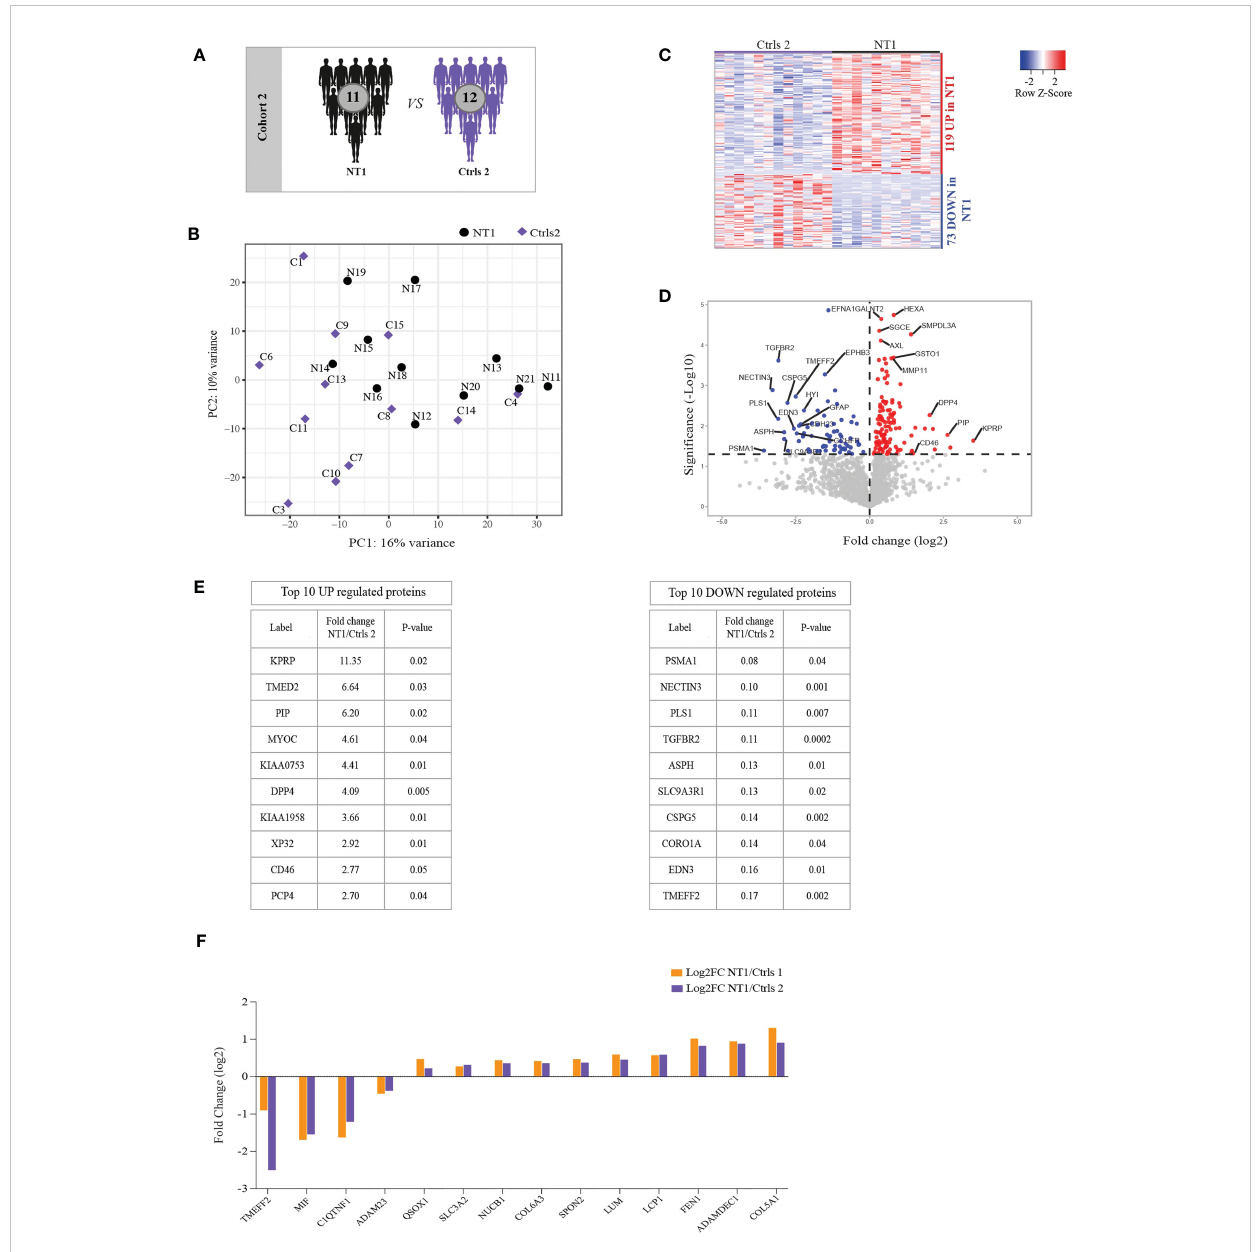
FIGURE 2 Differentially regulated proteins in the CSF of persons with NT1 compared to patients with other sleep disorders (OSD) and common proteins between cohorts. (A) In cohort 2, the proteomic analysis of the CSF from 11 NT1 patients was compared to that of 12 patients with OSD. (B) Principal Component Analysis (PCA) visualization of the fi rst two principal components. (C) Heatmap of differentially abundant proteins in the CSF of NT1 patients vs . OSD (p-value<0.05; Limma test). (D) Volcano plot representing the fold change (log2) of each protein in NT1 patients compared to OSD controls and the p value (-Log10), assessed with the Limma test. A signi fi cance threshold was set at p ≤ 0.05 (dashed line). (E) The top 10 up- regulated (left) and down-regulated (right) proteins in NT1 patients. (F) Shared congruently differentially regulated proteins between cohort 1 and cohort 2 and their log2 fold